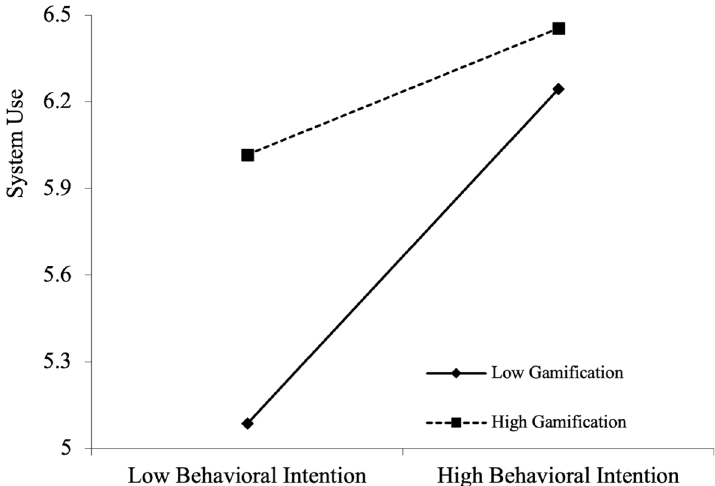
Fig. 2 Two-way interaction effects for regression analysis with system use (dependent variable, axis Y), behavioral intention (independent variable, axis X), and gamification as a moderator. All variables are measured by Likert scale from 1 (strongly disagree) to 7 (strongly